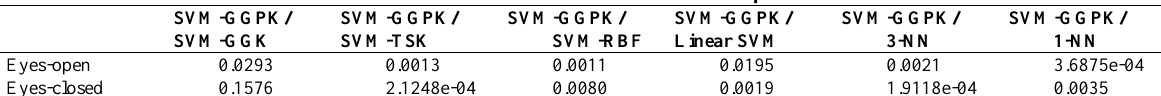
Table 9. p-value resulted by applying paired t-Test for comparison between SVM-GGPK and other compatitors on ADHD/BMD dataset in classification problem.